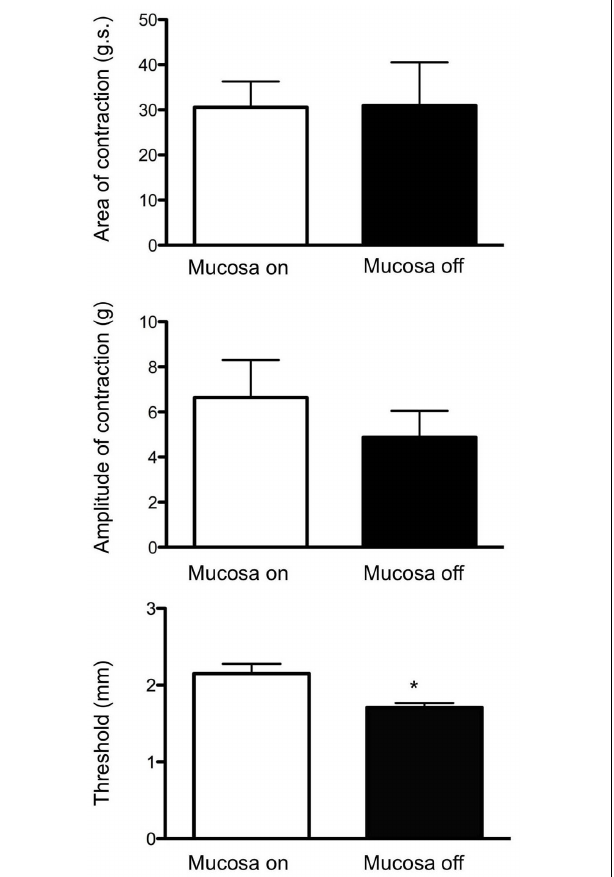
FIGURE 5 | Similarities and differences between spontaneous CMMCs in intact whole colon compared with spontaneous CMMCs occurring following removal of the mucosa and submucosal plexus. Following removal of the mucosa and submucosal plexus, there was no significant difference between the amplitude or area-under-contraction of spontaneous CMMCs before or after removal of the mucosa or submucosal plexus.The only significant difference was the interval between spontaneous CMMCs was significantly slower following removal of the mucosa and submucosal plexus.White boxes refer to control colon, while black bars refer to mucosa and submucosal plexus-free